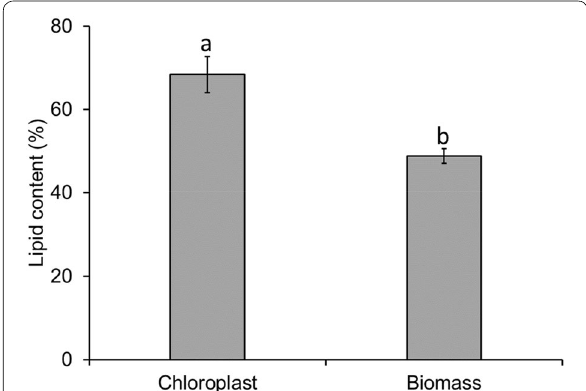
Fig. 4 Percent lipid content of isolated chloroplasts and whole cell biomass. Error bars represent standard error for n differences were found based on an α representing significant differences between samples. Lipid content was calculated based on modified Blight and Dyer method